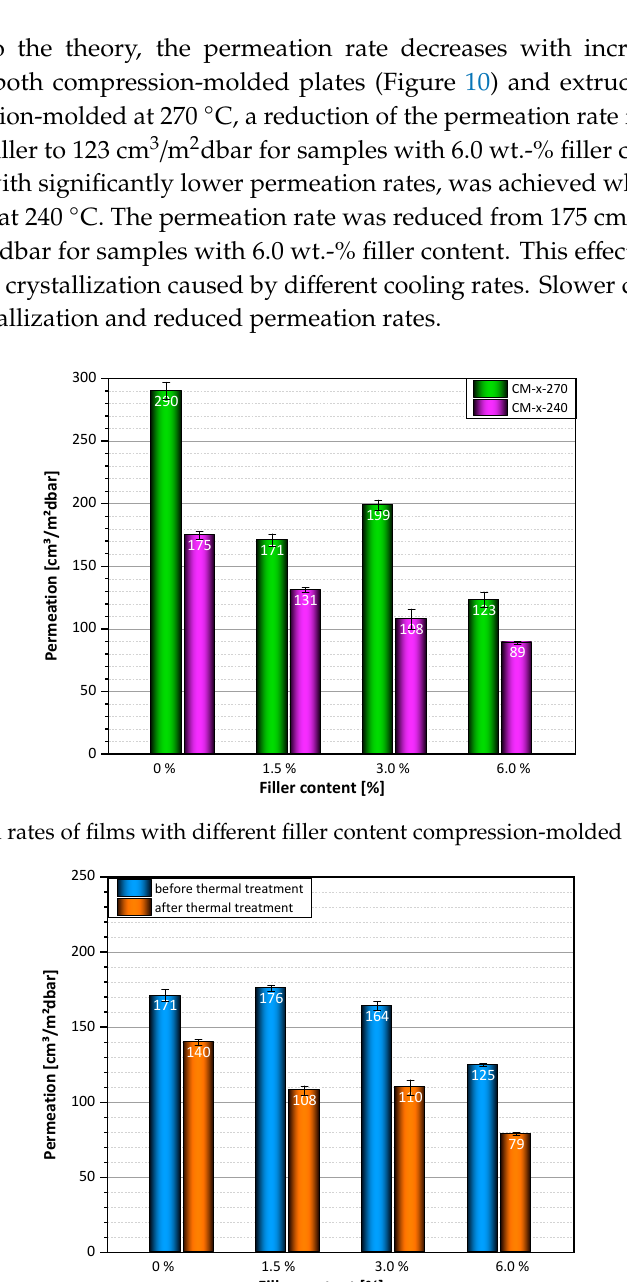
Figure 11. Permeation rates of melt-extruded films with different amount of fillers before and after thermal treatment.